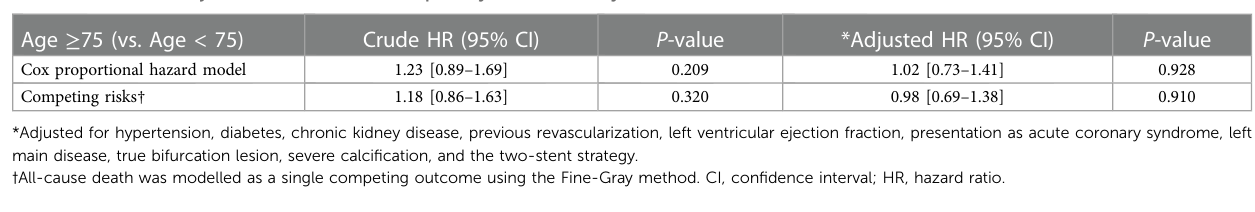
TABLE 4 Crude and adjusted hazard ratios of the primary outcome at 2